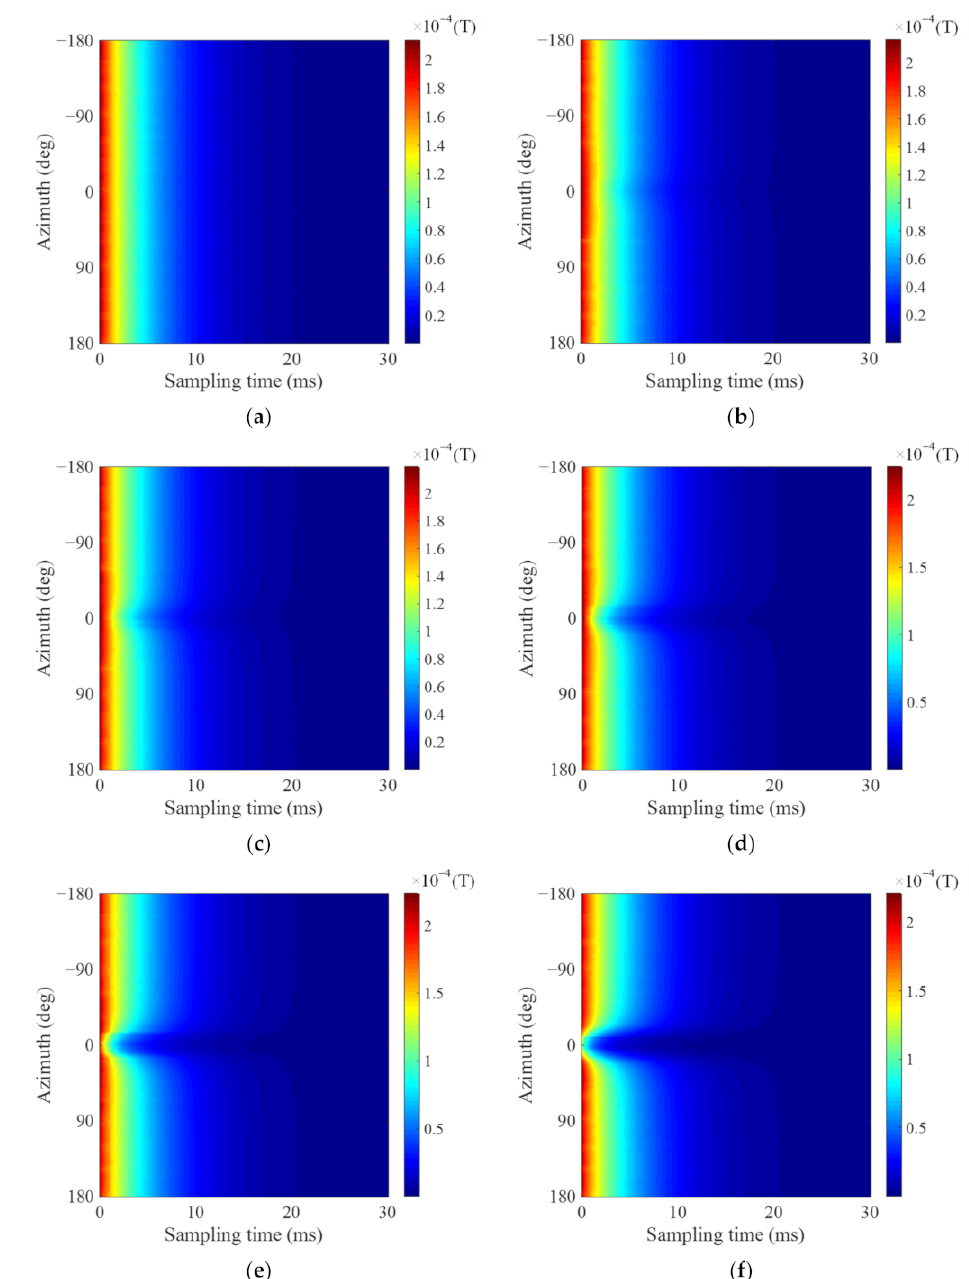
Figure 6. Azimuth-time images of MFDs for hole defects with different penetration depths (PD): ( a ) PD of 0% casing thickness; ( b ) PD of 20% casing thickness; ( c ) PD of 40% casing thickness; ( d ) PD of 60% casing thickness; ( e ) PD of 80% casing thickness; ( f ) PD of 100% casing thickness. A null exists at the same position of azimuth-time images of MFD for all PDs, and its shape differs with different PDs; thus, the shape and position of asymmetry defects of downhole casings can be determined. Moreover, the values of MFD at different sampling times show typical time-decay trend due to the diffusion of the eddy-current field. In the ra- dial direction, to obtain the PDs of hole defects, we analyze the original azimuth dimension curves at observation times of 10 and 20 ms, as shown in Figure 7a and Figure 7b,